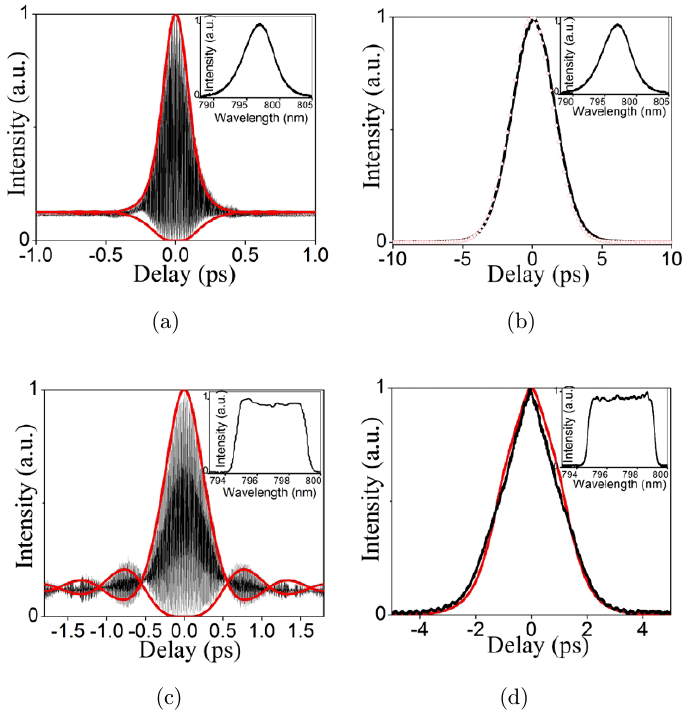
Fig. 4. (Color online) (a) and (b) Autocorrelation curves of output pulses with and without the dispersion compensation, re- spectively (no modulation on DMD). Black curve: experimental curves; red curve: theoretical curves. Inset: initial spectrum. (c) and (d) Autocorrelation curves of output pulses with and without the dispersion compensation, respectively (rectangle modulation on DMD). Black curve: experimental curves; red curve: theoretical curves. Inset: spectrum of the shaped